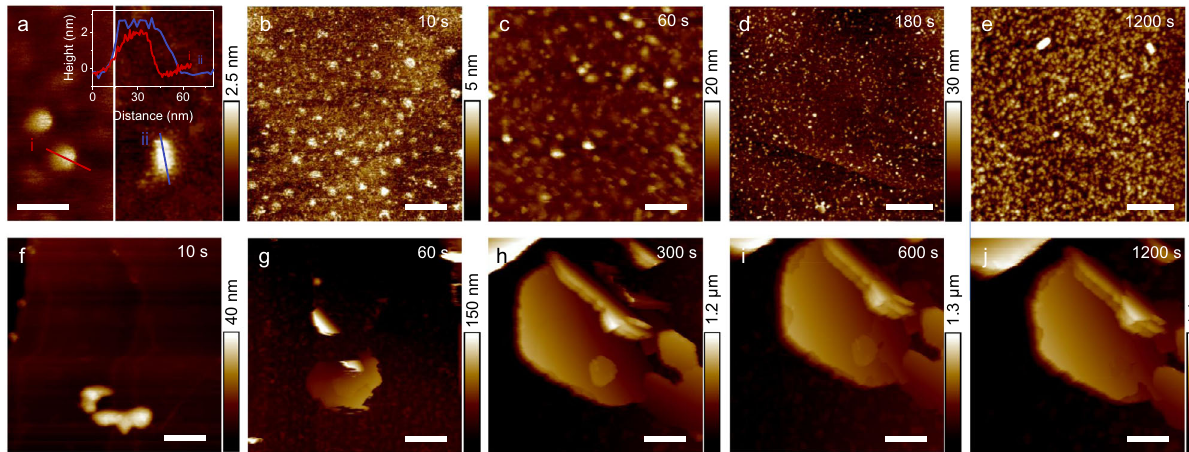
Fig. 2 | The electrochemical behavior of Zn 2+ ions. a Pristine C 3 N 4 QDs on mica (left) and the C 3 N 4 QDs in ZnSO 4 aqueous electrolyte on HOPG (right), the inset is the height pro fi les of the corresponding lines; In situ AFM images of Zn